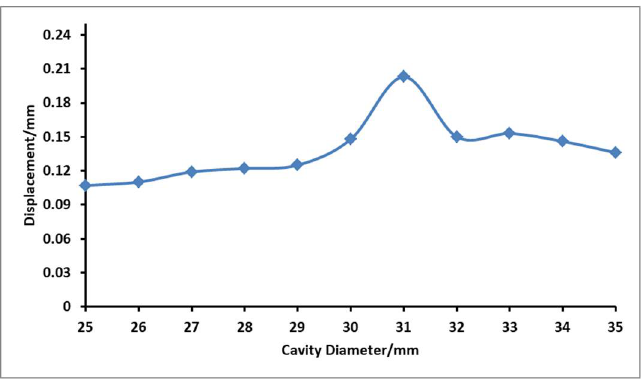
Figure 9. Curves of the relationship between different cavity diameters and flexible film displacement.